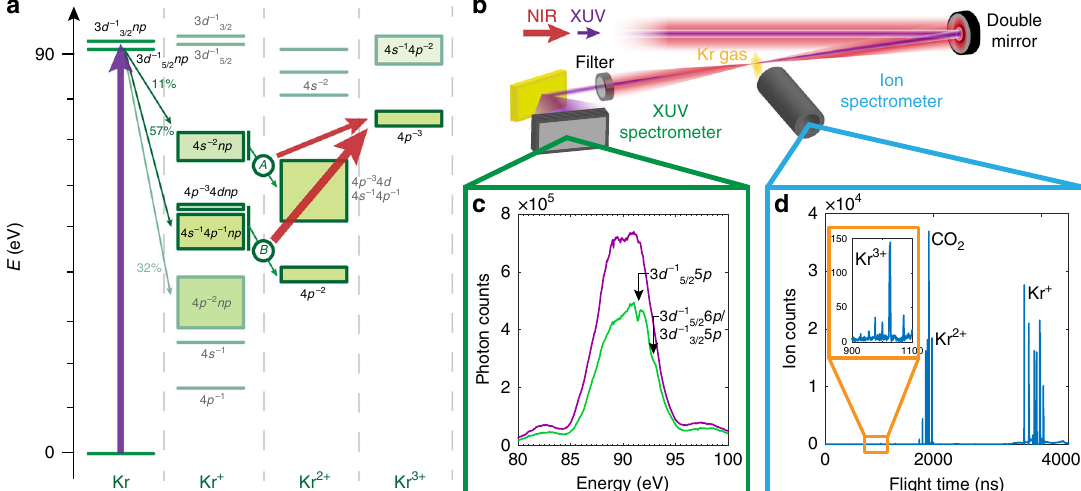
Fig. 1 Overview of the experiment. a Krypton excitation and decay scheme. The XUV pulse excites the 3 d − 1 5/2 np /3 d − 1 3/2 np states (violet arrow) that can decay via different Auger cascades (green arrows). Depending on the NIR laser intensity, the different intermediate Kr + states can be further ionized to Kr 3+ : at low NIR intensities, the intermediate 4 s − 2 np states can be ionized to Kr 3+ (thin red arrow, I NIR = (8.6 ± 1) × 10 13 W cm − 2 ), at higher NIR intensities, the 4 p − 3 4 dnp /4 s − 1 4 p − 1 np states can be ionized to Kr 3+ (thick red arrow, (2.9 ± 0.5) × 10 14 W cm − 2 ). The direct XUV ionization and the corresponding decay channels are not shown for the sake of clarity, but are considered in the data analysis. For a more detailed fi gure see refs. 17,31